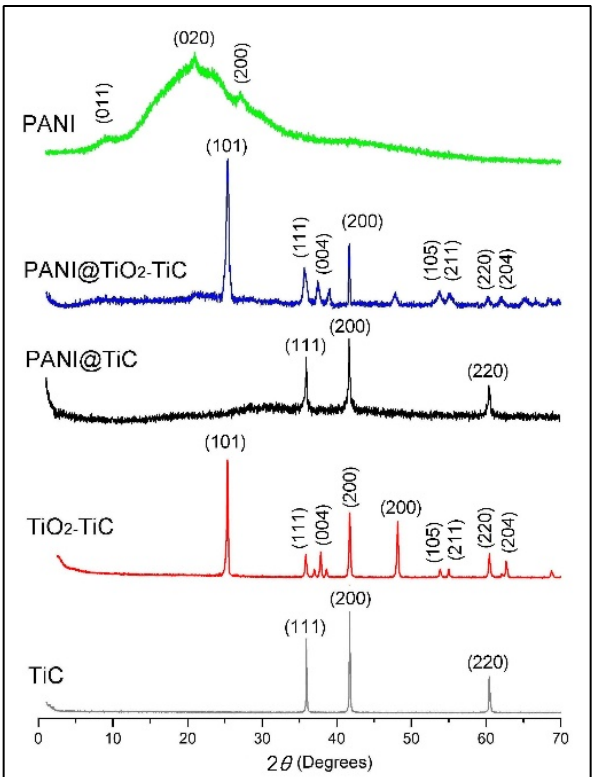
Figure 4. X-ray diffraction (XRD) patterns of the samples. The studied materials are clearly displayed on their transmission electron microscopy (TEM) images in Figure 5. The TiC in Figure 5a appears almost spherical and distributed on the supports. Moreover, we found that the TiO 2 –TiC composite does not significantly change the size of neat TiC, as shown in Figure 5c. This TEM analysis confirmed that the TiO 2 –TiC composite was synthesized and successfully prepared from TiC. Further- more, TEM (Figure 5b,d) revealed the relatively small-sized TiC and TiO 2 –TiC dispersed and anchored on the PANI backbone in the PANI@TiC and PANI@TiO 2 –TiC compos- ites, respectively. The result of the TEM analysis suggests that hybrid materials were completely